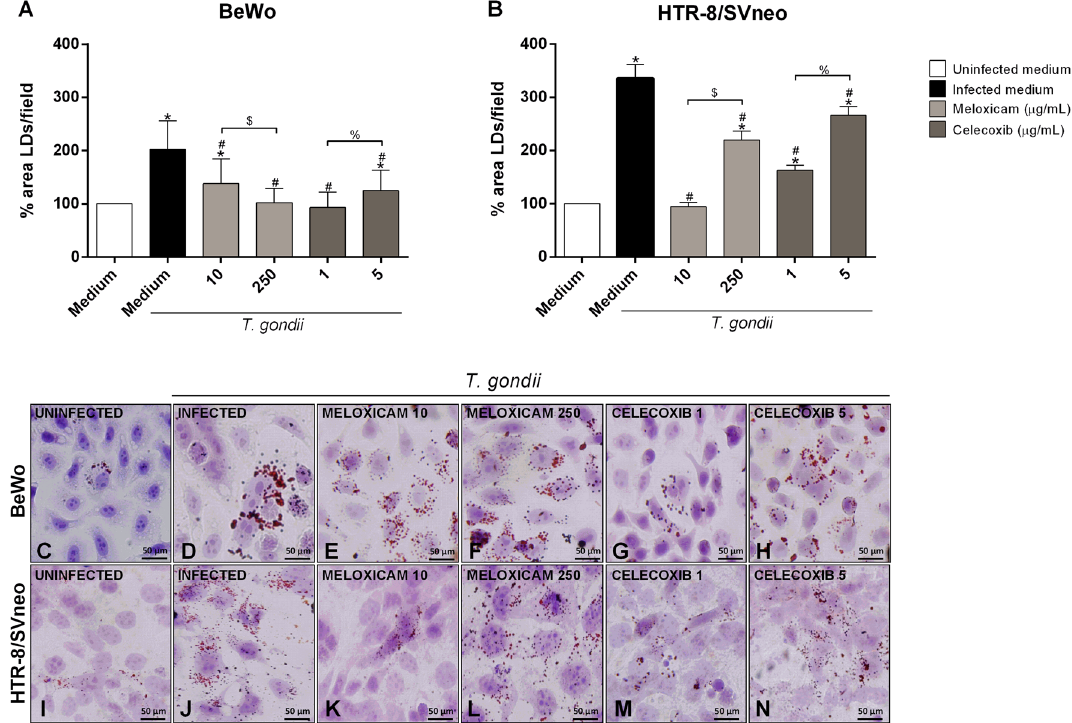
Figure 6. LDs production in BeWo and HTR-8/SVneo cells infected with T. gondii and treated with COX-2 inhibitors. BeWo ( A ) and HTR-8/SVneo ( B ) cells were infected or not with T. gondii for 3 h and treated or not with meloxicam or celecoxib for an additional 24 h. Next, cells were stained with Oil Red O (0.5%) for visualization of LDs, and 40 images from differents fields for each condition were analyzed by the Image J software version 1.50i (National Institutes of Health, USA, https:// imagej. nih. gov/ ij). Data were presented as percentage (%) of area LDs/field in relation to uninfected and untreated cells (100% area LDs). Data were shown as mean ± SEM from three independents experiments with four replicates. Differences between groups were analyzed by Kruskal–Wallis test and Dunn’s multiple comparison post-test (GraphPad Prism Sofware version 6.01, https:// www. graph pad. com). Significant differences in relation to untreated and uninfected cells ( * uninfected medium), untreated and infected cells ( # infected medium), and between concentrations of meloxicam ( $ ) or celecoxib ( % ). Differences were considered significant when P < 0.05. Representative photomicrographs are shown in BeWo ( C – H ) and HTR-8/SVneo cells ( I – N ) uninfected and untreated ( C , I ), infected and untreated ( D , J ), infected and treated with 10 μg/mL meloxicam ( E , K ), or 250 μg/mL ( F , L ), or infected and treated with 1 μg/mL celecoxib ( G , M ), or 5 μg/mL ( H , N ). Staining by Oil Red O and Harris- hematoxylin. Bar scale: 50.0